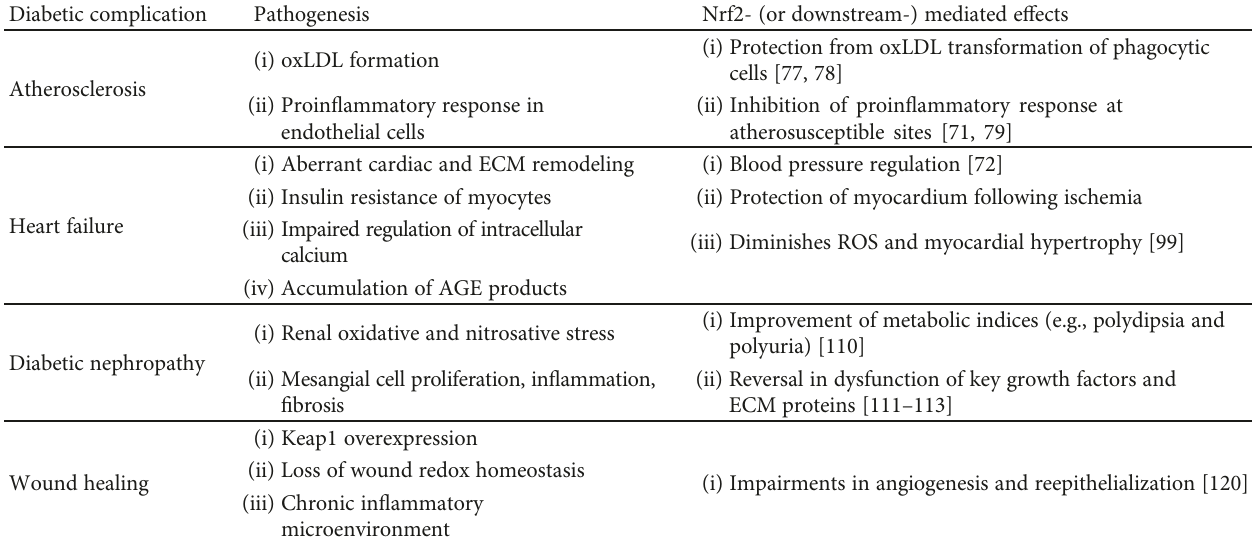
Table 1: Nrf2/Keap1/ARE and diabetic